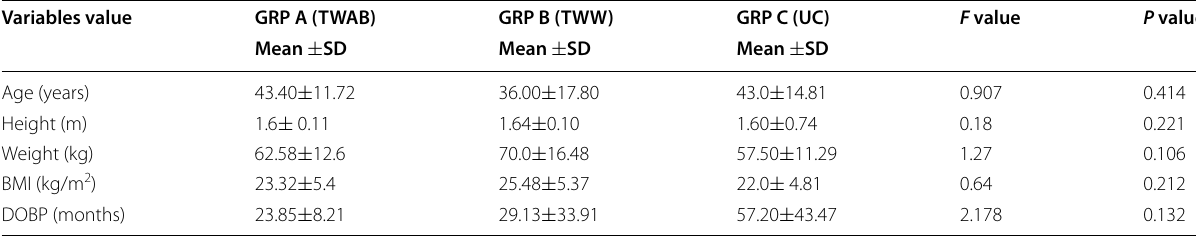
Table 1 Participants’ socio-demographic characteristics at